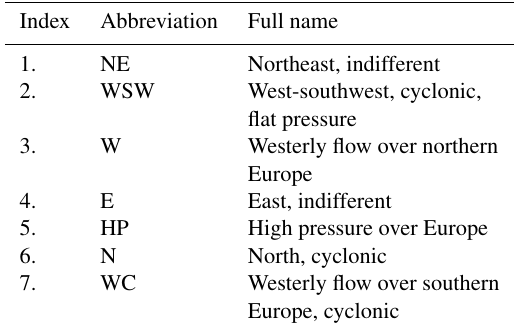
Table 1. CAP7 weather types numbers, abbreviations, and